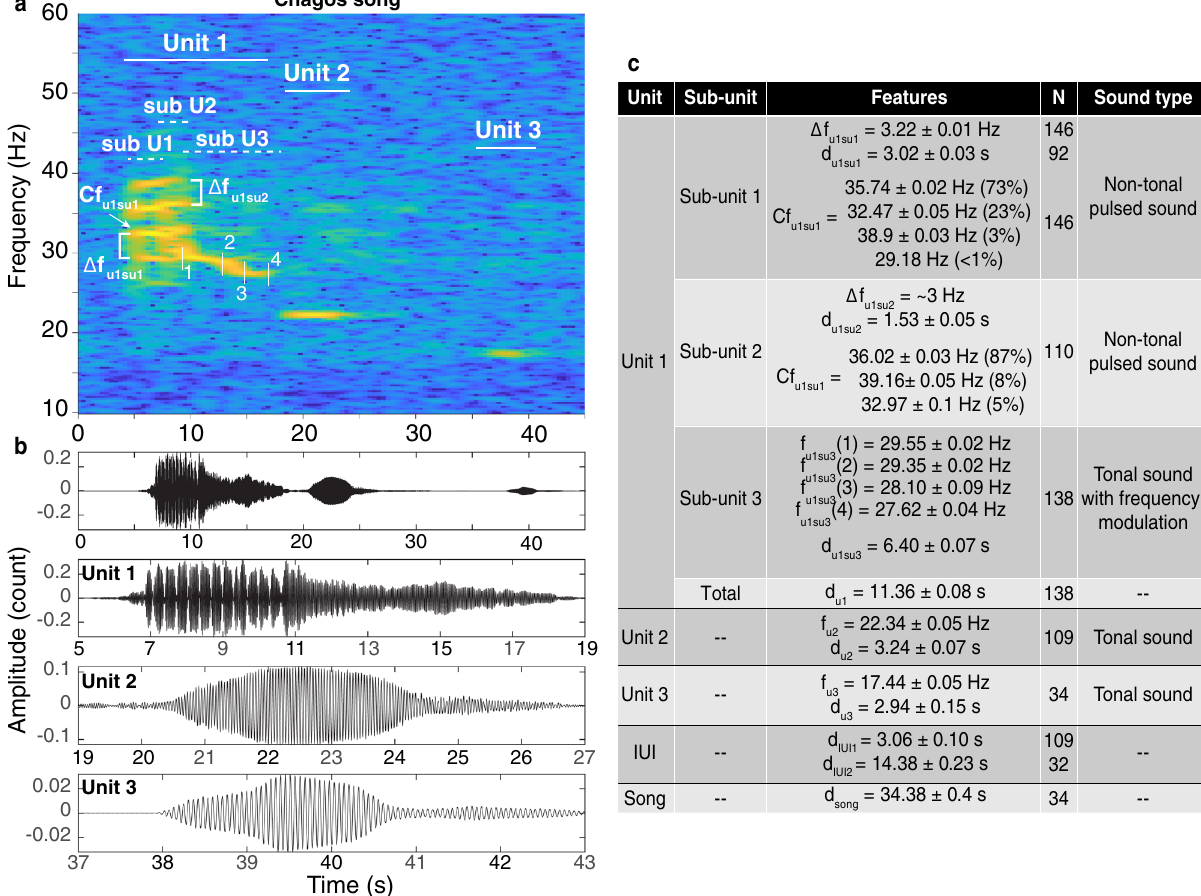
Figure 3. Spectrogram ( a ) and waveforms ( b ) of a Chagos song recorded on the eastern side of the Chagos Archipelago (DGS) in August 2017. Detailed waveforms show the signal structure of the units within the song. Spectrogram parameters: Hamming window, 1024-point FFT length, 90% overlap. Note that the axes differ among plots. ( c ) Measurements (mean ± standard error (s.e.)) of the acoustic features. N is the number of measurements, u i su j stands for unit i subunit j where i and j are the unit and subunit numbers, (cid:31) f designates the frequency difference between the sidebands, f and d are the frequency and duration of the feature indicated in subscript, and when present, the number in brackets refers to the point measured as indicated on the spectrogram. F x or G x designate the x th harmonic of a sound, and Cf designates the carrier frequency of a